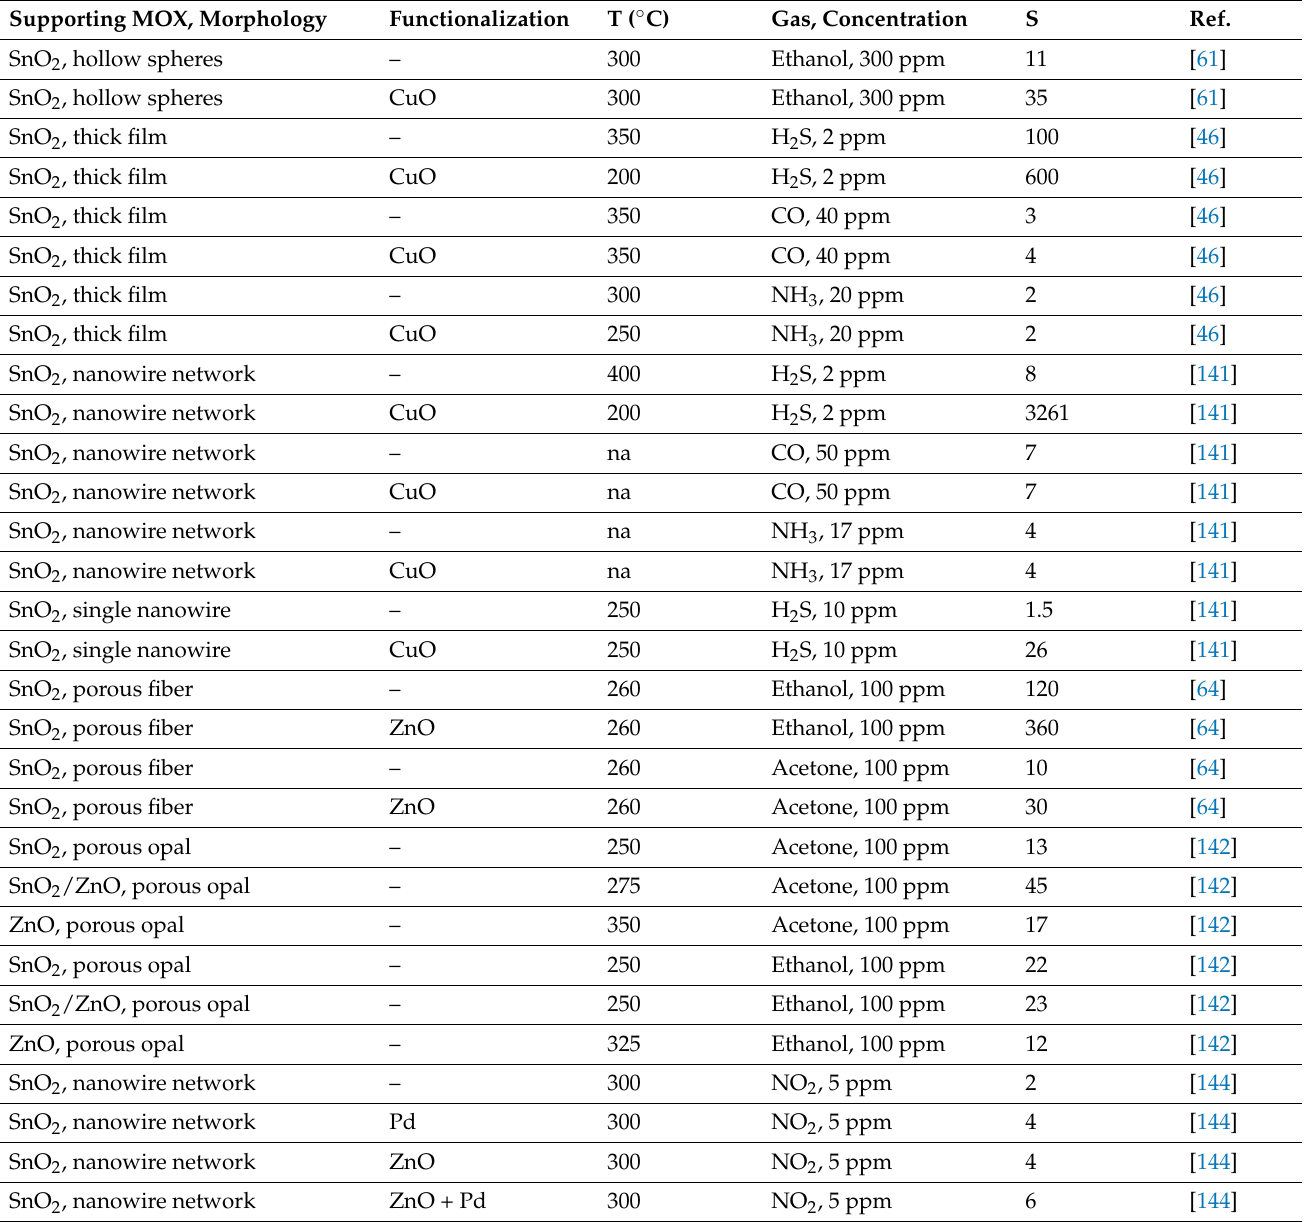
Table 3. Chemiresistors based on metal oxide (MOX) nanostructures functionalized with metal oxide nanoparticles. The response intensity S is calculated as S = R air /R gas for reducing gases and as S = R gas /R air for NO 2 at the sensor temperature (T). Gas concentrations are expressed in parts per million (ppm). In those cases in which information is not available from the original reference, the related cell reports